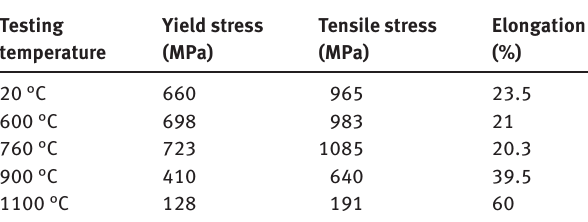
Table 1: Tensile property of aged alloy